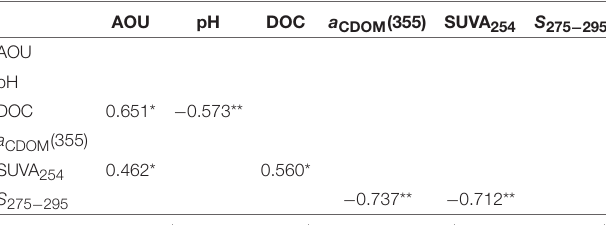
TABLE 1 | Pearson correlations between various parameters in the bottom layer in August of 2016.